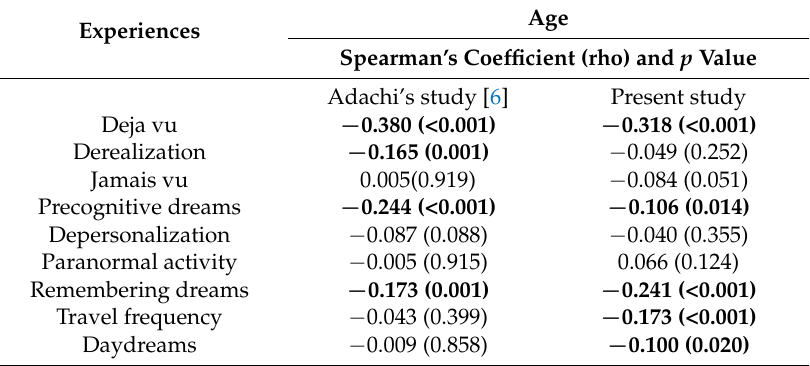
Table 2. Correlation between age and the IDEA